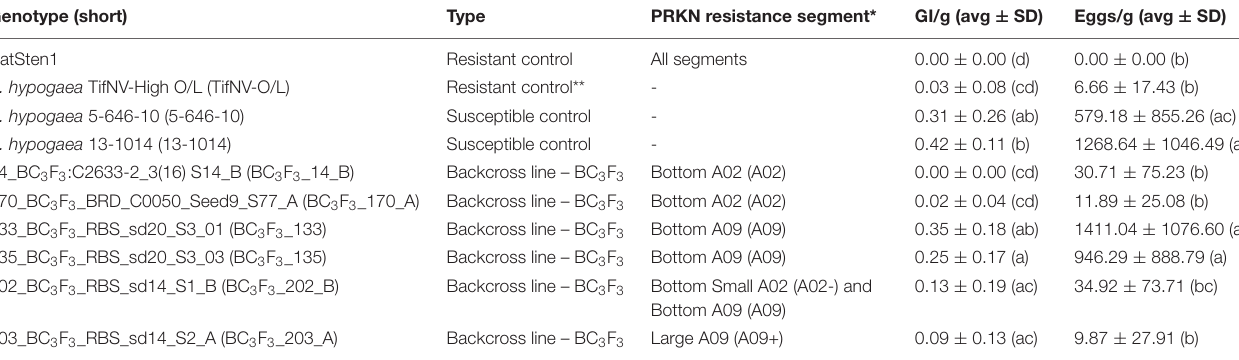
TABLE 1 | Average and standard deviation for GI/g and eggs/g measured in BC 3 F 3 lines, resistant, and susceptible controls using a pot bioassay. Genotype (short)